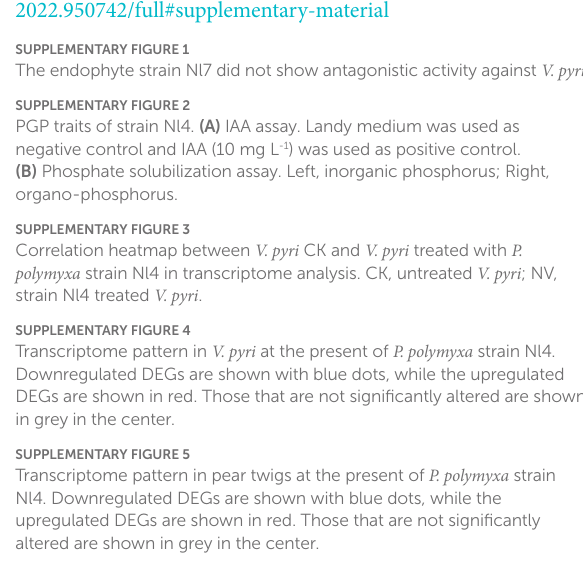
SUPPLEMENTARY FIGURE 1 The endophyte strain Nl7 did not show antagonistic activity against V. pyri. SUPPLEMENTARY FIGURE 2 PGP traits of strain Nl4. (A) IAA assay. Landy medium was used as negative control and IAA (10 mg L -1 ) was used as positive control. (B) Phosphate solubilization assay. Left, inorganic phosphorus; Right, organo-phosphorus. SUPPLEMENTARY FIGURE 3 Correlation heatmap between V. pyri CK and V. pyri treated with P. polymyxa strain Nl4 in transcriptome analysis. CK, untreated V. pyri ; NV, strain Nl4 treated V. pyri . SUPPLEMENTARY FIGURE 4 Transcriptome pattern in V. pyri at the present of P. polymyxa strain Nl4. Downregulated DEGs are shown with blue dots, while the upregulated DEGs are shown in red. Those that are not significantly altered are shown in grey in the center. SUPPLEMENTARY FIGURE 5 Transcriptome pattern in pear twigs at the present of P. polymyxa strain Nl4. Downregulated DEGs are shown with blue dots, while the upregulated DEGs are shown in red. Those that are not significantly altered are shown in grey in the